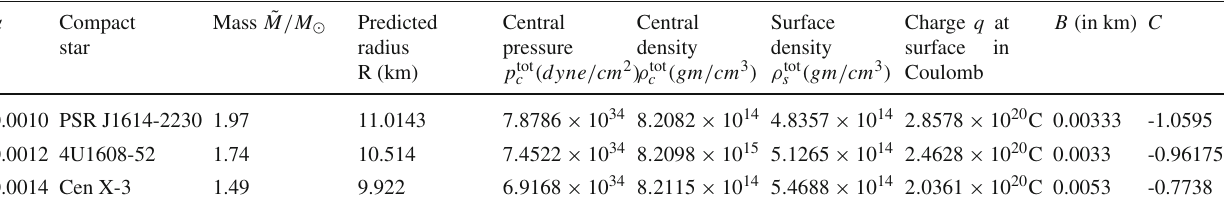
Table 1 The numerical values of mass, radius, central pressure, cen- tral density, surface density, electric charge at surface and constants B and C of the different compact objects, namely PSRJ1614-2230